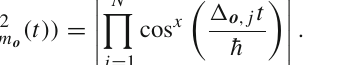
( |↑(cid:6) +|↓(cid:6) )( (cid:12)↑ s s s 2